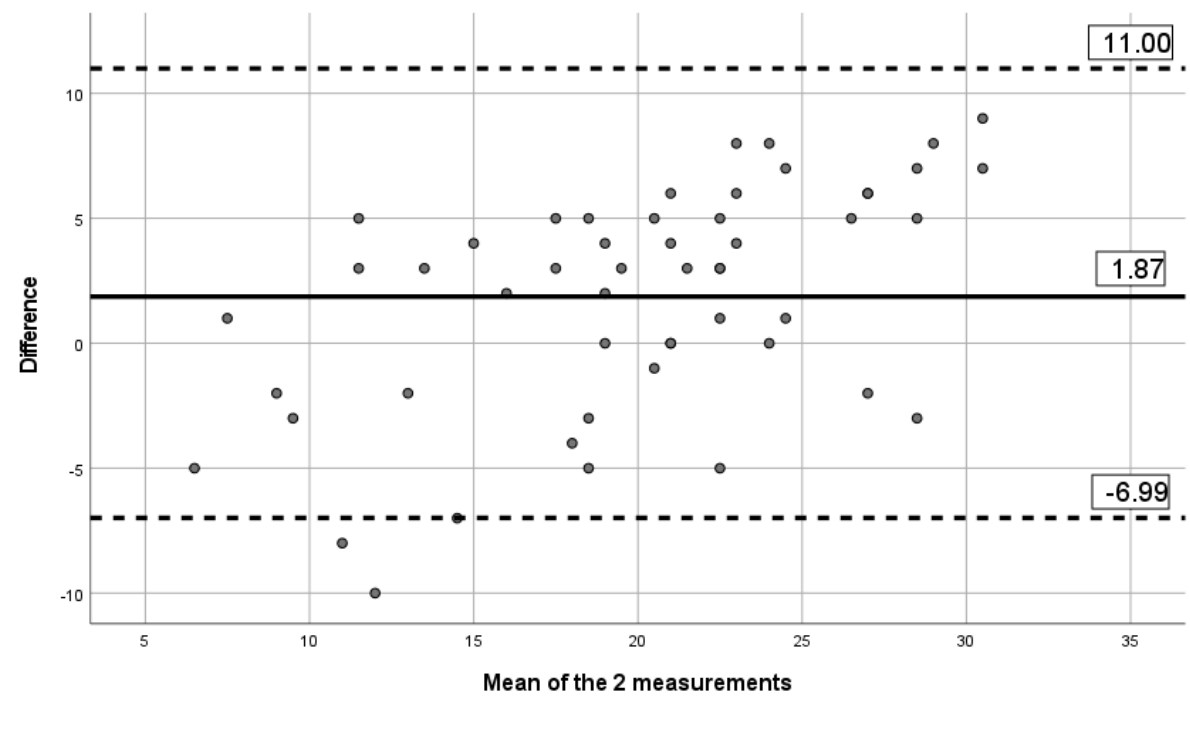
Figure 9. Bland-Altman limits for the Brief Pain Inventory pain severity subscale using the paper questionnaire and the mobile app.